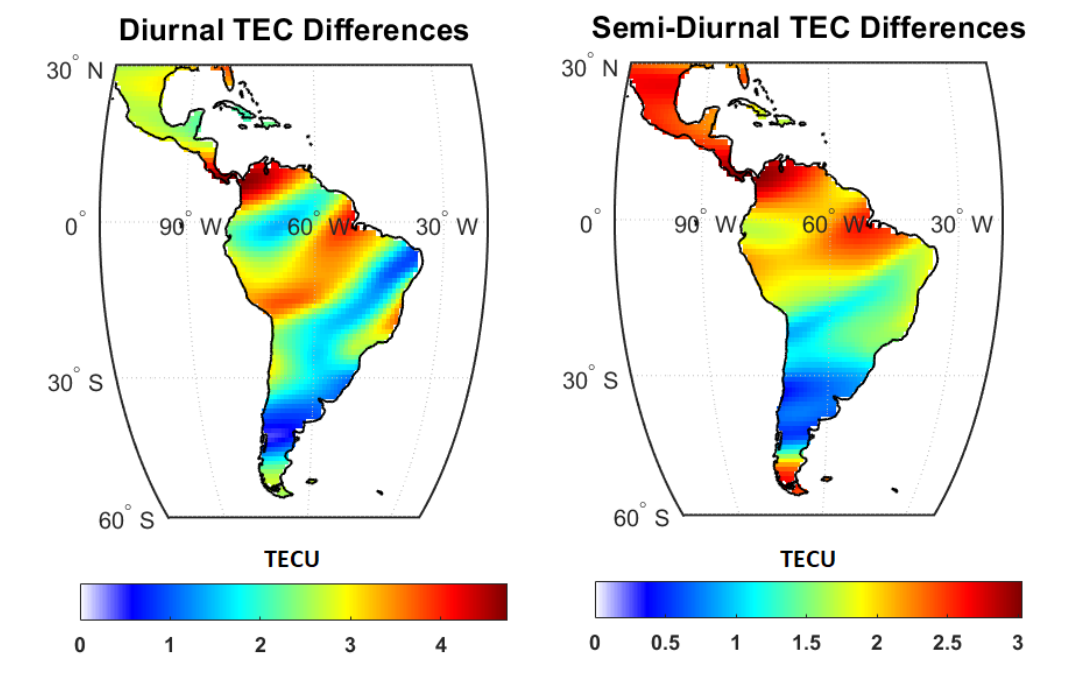
Figure 7. The amplitudes of diurnal ( left ) and semi-diurnal ( right ) VTEC differences (regionalized estimates—GIM/CODE) during